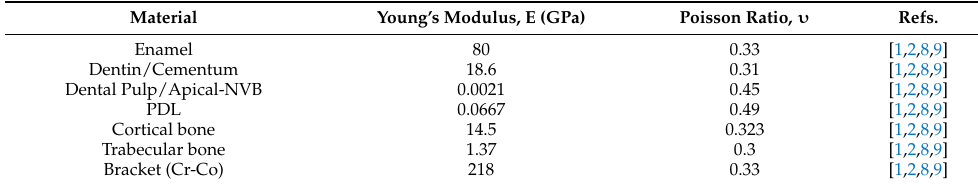
Figure 1. Mesh model: ( A ) 2nd lower-right premolar model, with intact periodontium, ( B ) 4 mm bone loss, ( C ) 8 mm bone loss, ( D ) dental pulp with apical NVB, distal-vestibular view, ( E ) 2nd premolar with bracket, 4 mm bone loss, ( F ) PDL and dental pulp, cervical-coronal view; applied load vectors: ( G ) intrusion, ( H ) extrusion, ( I ) translation, ( J ) rotation, ( K ) tipping, ( L ) PDL with apical NVB, apical view, ( M ) apical NVB and radicular pulp, apical third. Table 1. Elastic properties/physical properties of materials in GPa.